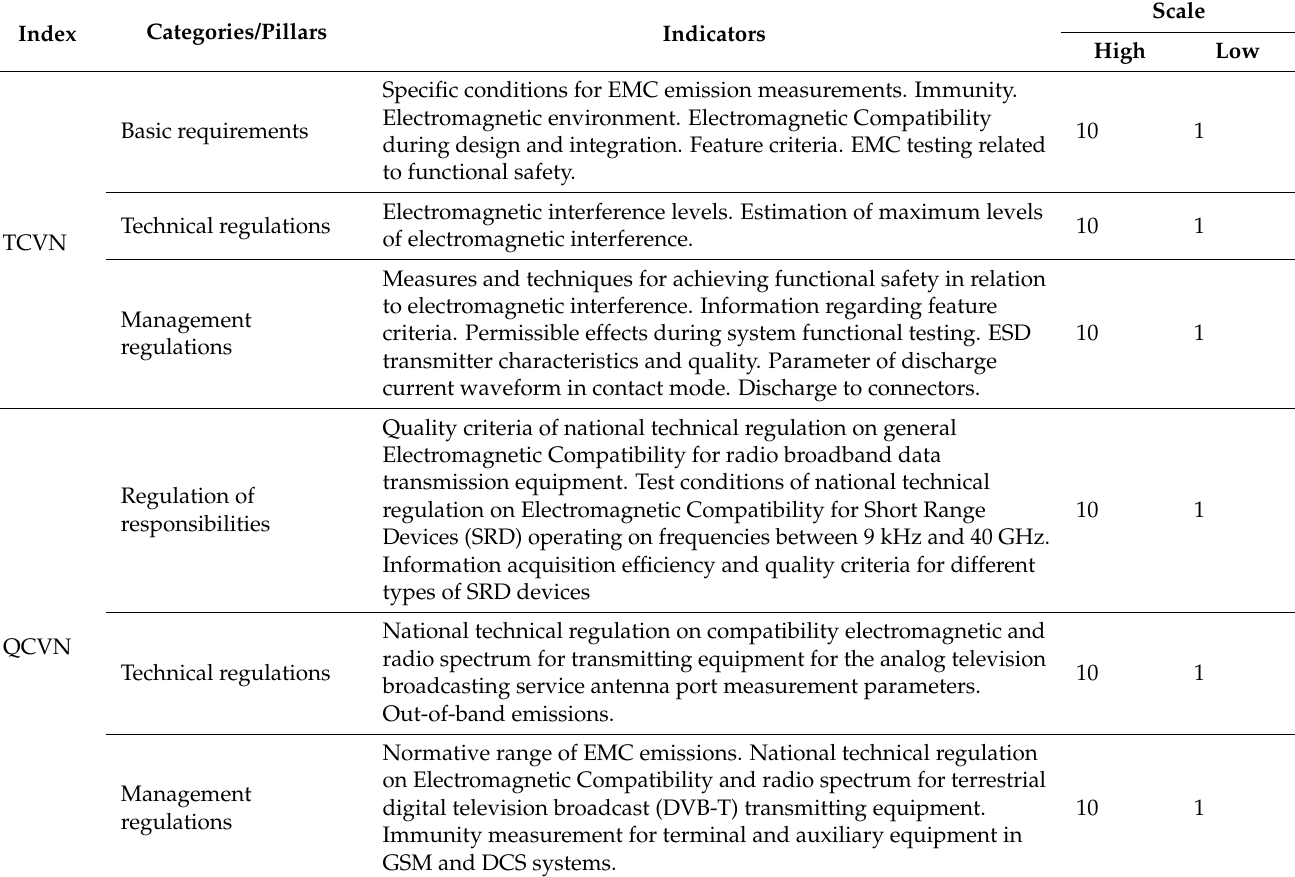
Table 1. Data sources and scales.